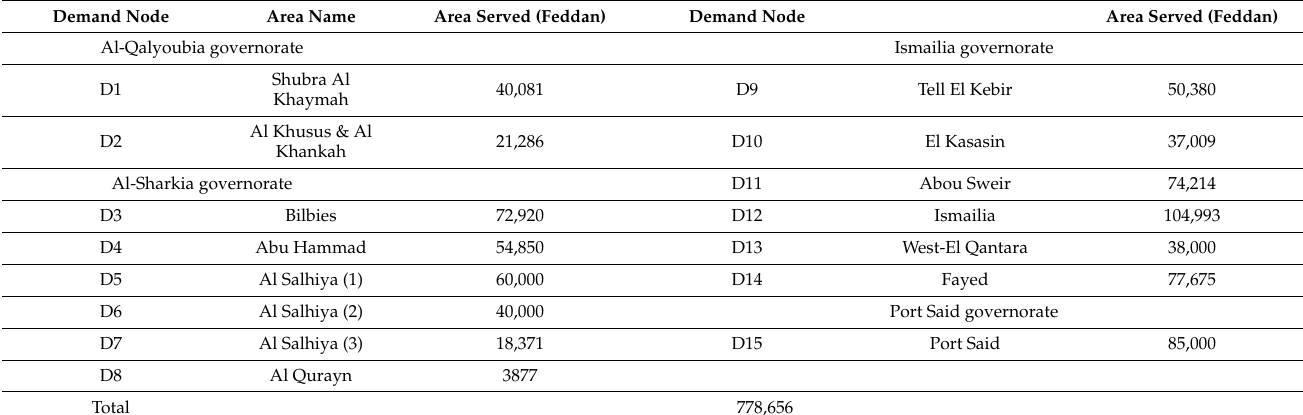
Table 4. Name and area served of each agriculture demand node [33,36].